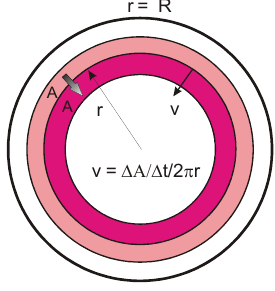
Figure 2. Continuous model of radial inward fuel